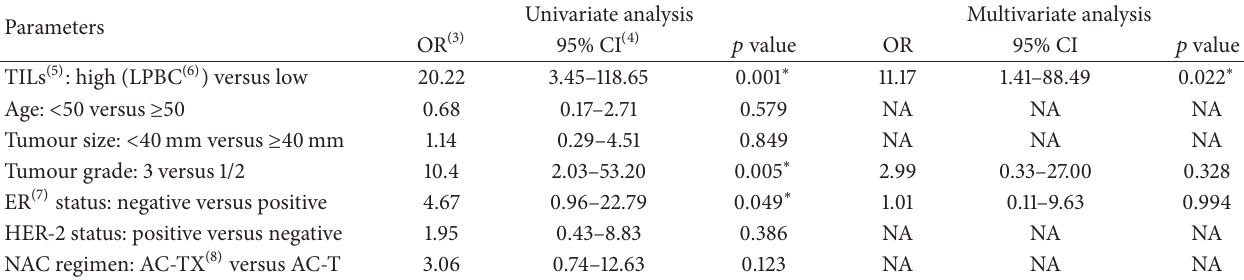
Table 10: Univariate and multivariate (logistic regression) analyses of clinicopathological parameters as predictive factors for pathological complete response to NAC (1) in LLABCs (2) ( 𝑛 = 33